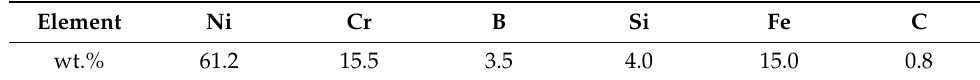
Table 1. Chemical composition of NiCrBSi powders.